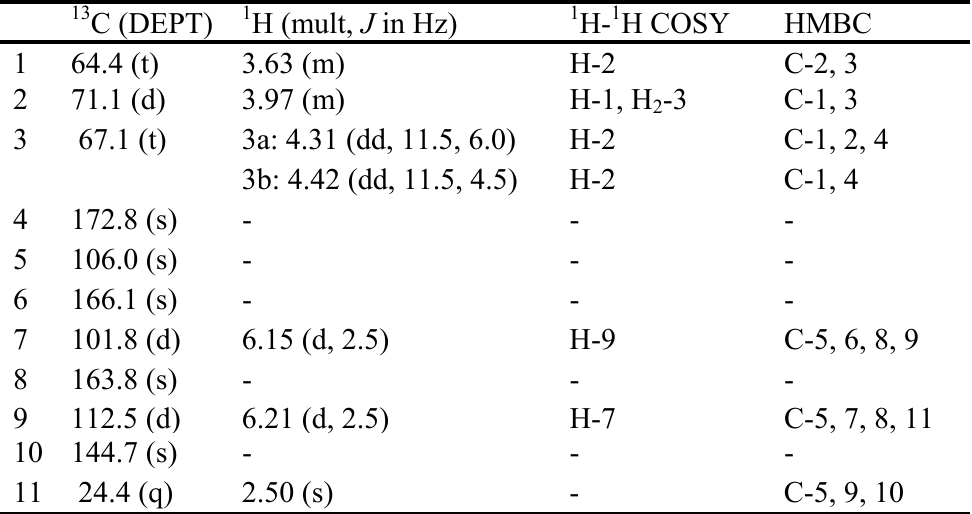
OD, δ in ppm, J in 3